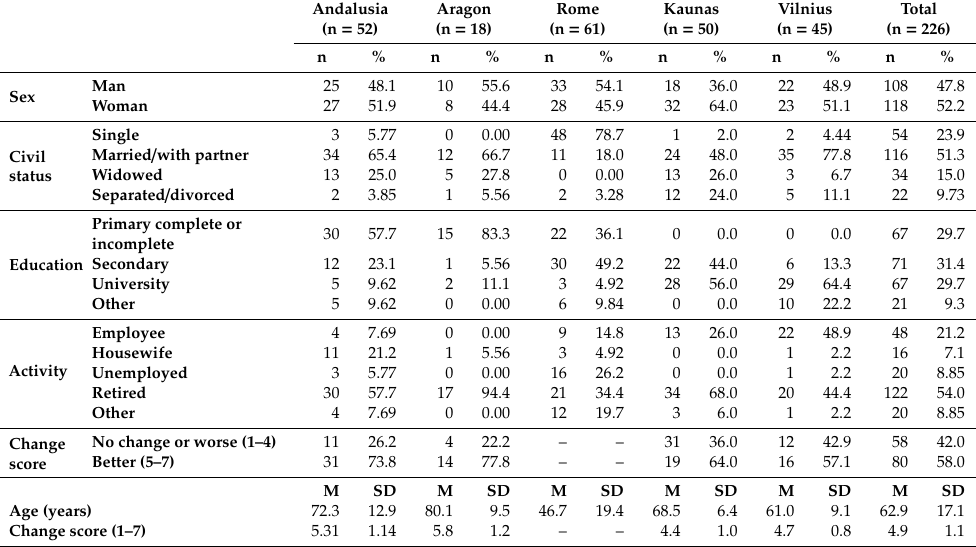
Table 2. Socio-demographic characteristics of patients and self-reported change score by the implementing